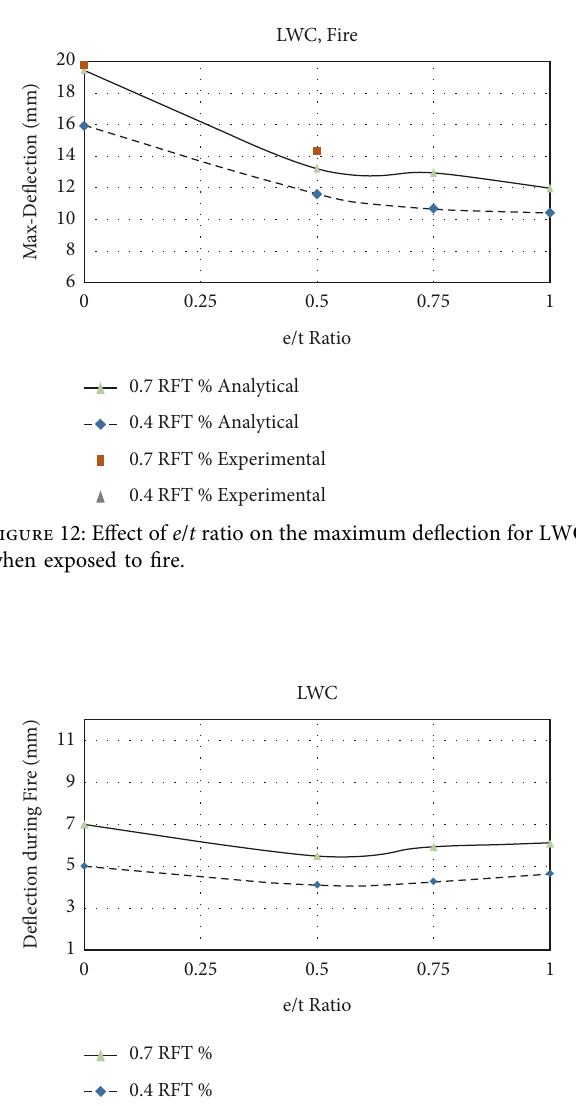
Figure 13: Effect of e/ t ratio on the deflection during fire process at constant load for LWC.